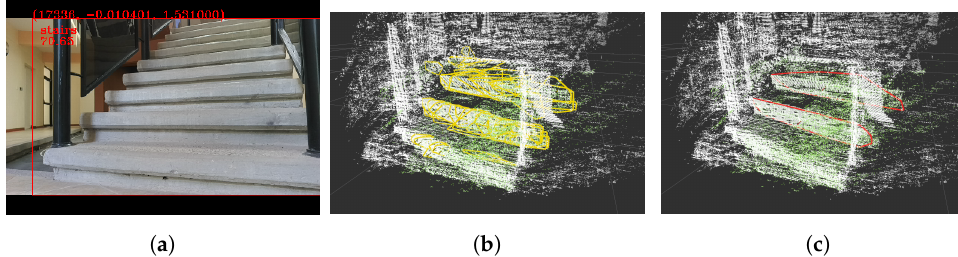
Figure 10. Results obtained using the OAK-D camera pipeline: ( a ) staircase detection, ( b ) smooth region segmentation, ( c ) clustering of smooth regions.